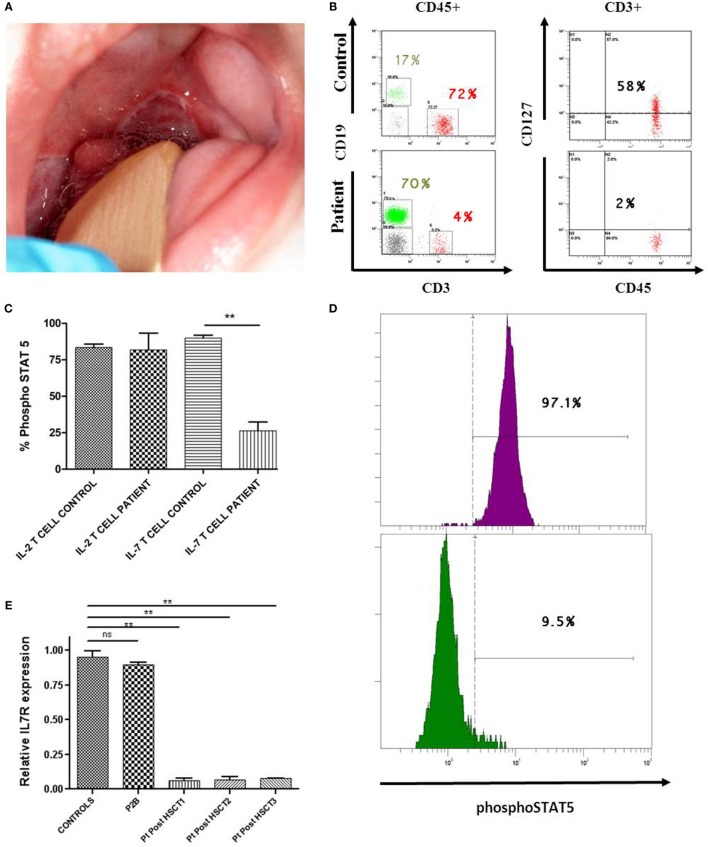
Immune evaluation of patient deficient in IL-7R. (A) Two major aphthous oral ulcers (large ulcers greater than 10 mm in diameter) in a 5-month-old male, involving the posterior veil of soft palate. (B) Lower CD127 expression on CD3 T-cells of IL-7R-deficient patient compared with a healthy donor. (C,D) Significantly lower phosphorylation of STAT5 (phosphoSTAT5, BD biosciences) in response to IL-7 (R&D systems) was observed in T-cells from the patient post-HSCT (IL-7 T cell patient) compared with the healthy donor (IL-7 T cell control). An example of phosphorylation of STAT5 with IL-7 in T-cells from the control (in purple) vs. phosphorylation of STAT5 with IL-7 in T-cells from the patient post-HSCT (in green). Normal phosphoSTAT5 in response to IL-2 (Roche) was observed in the patient (IL-2 T cell patient) and the healthy donor (IL-2 T cell control) (n = 2). Statistical comparison was performed with unpaired Student’s t-tests, with significance defined as **P < 0.01; ns: not statistically significant. (E) Impaired IL7R gene expression in CD3 T-cells from IL-7R-deficient patient 1, 2, and 3 years post-HSCT (Pt post-HSCT 1, 2, and 3). These results were compared with P2B (IL-7R-deficient patient with complete immune reconstitution after 19 years post-HSCT) and 10 healthy children donors. GADPH was used as the endogenous gene control. Triplicate data from one experiment are shown.